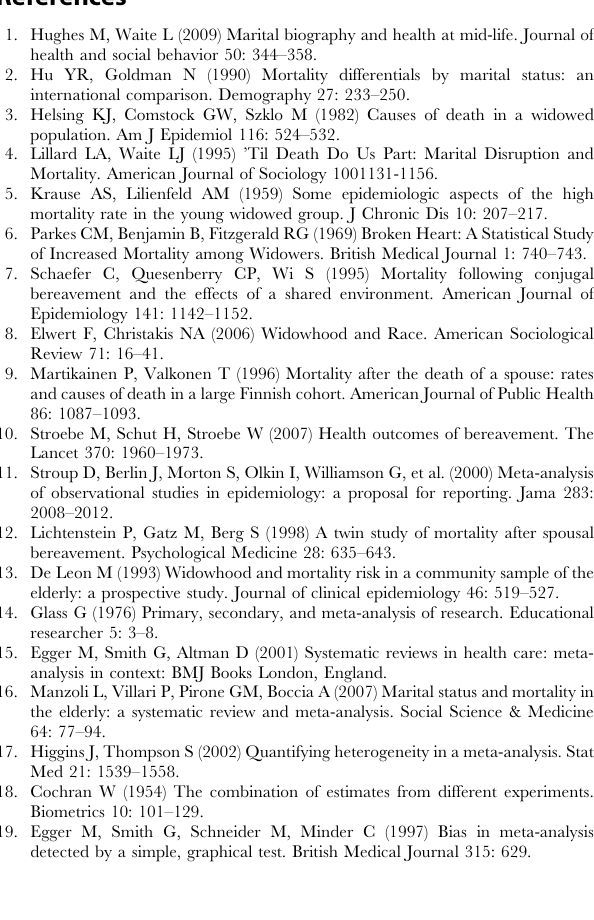
Table S1 PubMed Search Strategy. Table S2 List of extracted studies.